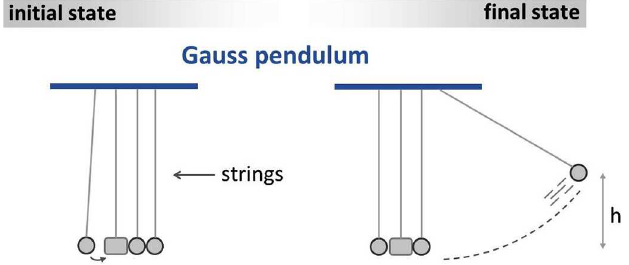
Fig. 2. Sketch depicting a Gauss